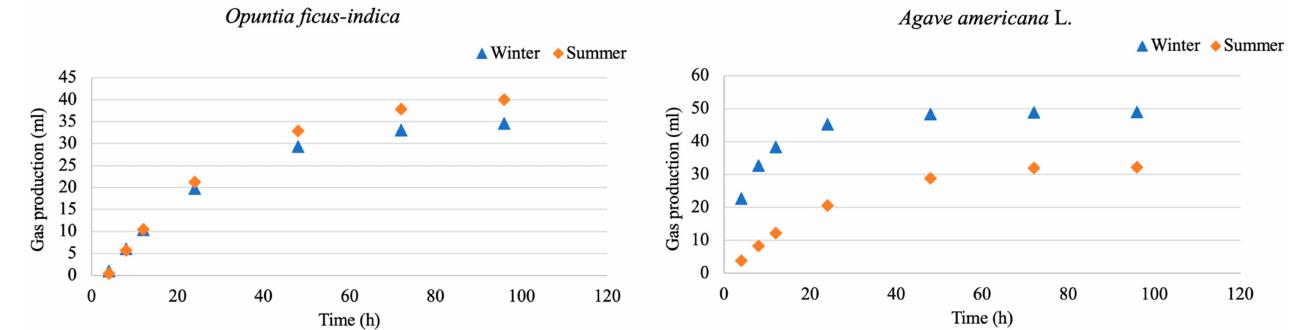
Figure 2. Cumulative fitted values of gas production of the different plants in the two periods. Out of the parameters evaluated in the kinetics of in vitro gas production (Table 3), no significant differences were observed between the lag time values. Except for parameter b , for Opuntia ficus-indica , all the other parameters differed ( p < 0.05) statistically between the two seasons of the year under analysis. Table 3. In vitro gas production kinetics parameters of the different plants in the two periods. Opuntia ficus-indica Agave americana L. Parameter Period Period Winter Summer Winter Summer a (mL/0.2 g DM) − 4.87